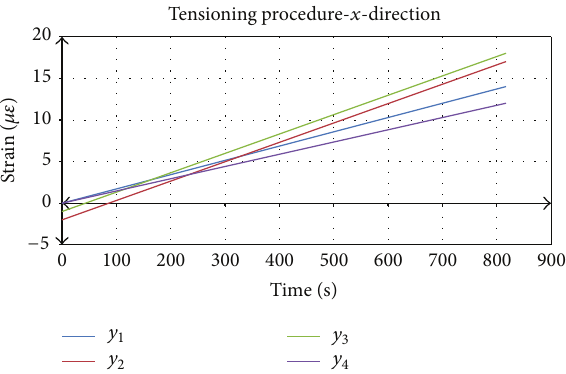
Figure 37: Strains parallel to applied axial compression.